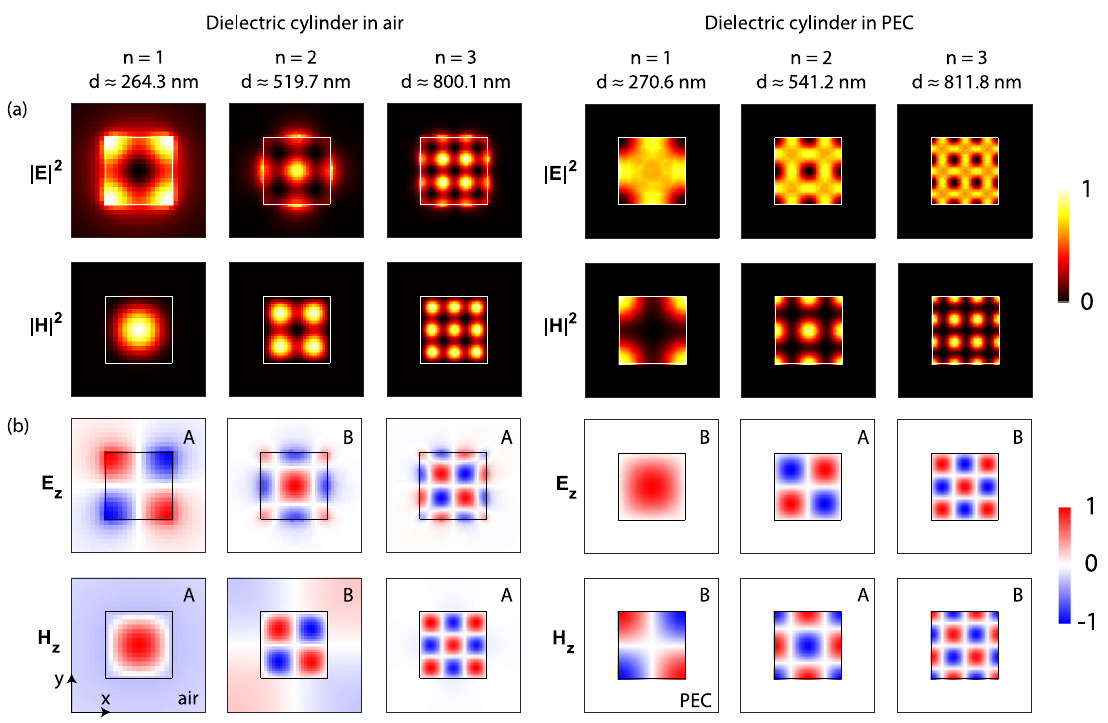
Figure6: (Coloronline)Intensity(a)and z -projection(b)ofelectricandmagnetic fi eldsofDSCMsat n (cid:1) 1 − 3calculatedforthecasesofairand PECboundaries.SymbolsA orBdenoteirreduciblerepresentationsofthe S 4 pointgroup. ε 1 (cid:1) 9, ε 2 (cid:1) 36, λ (cid:1) 1550nm.Colorscales areshown on the right. DSCM, Dyakonov-like surface cavity